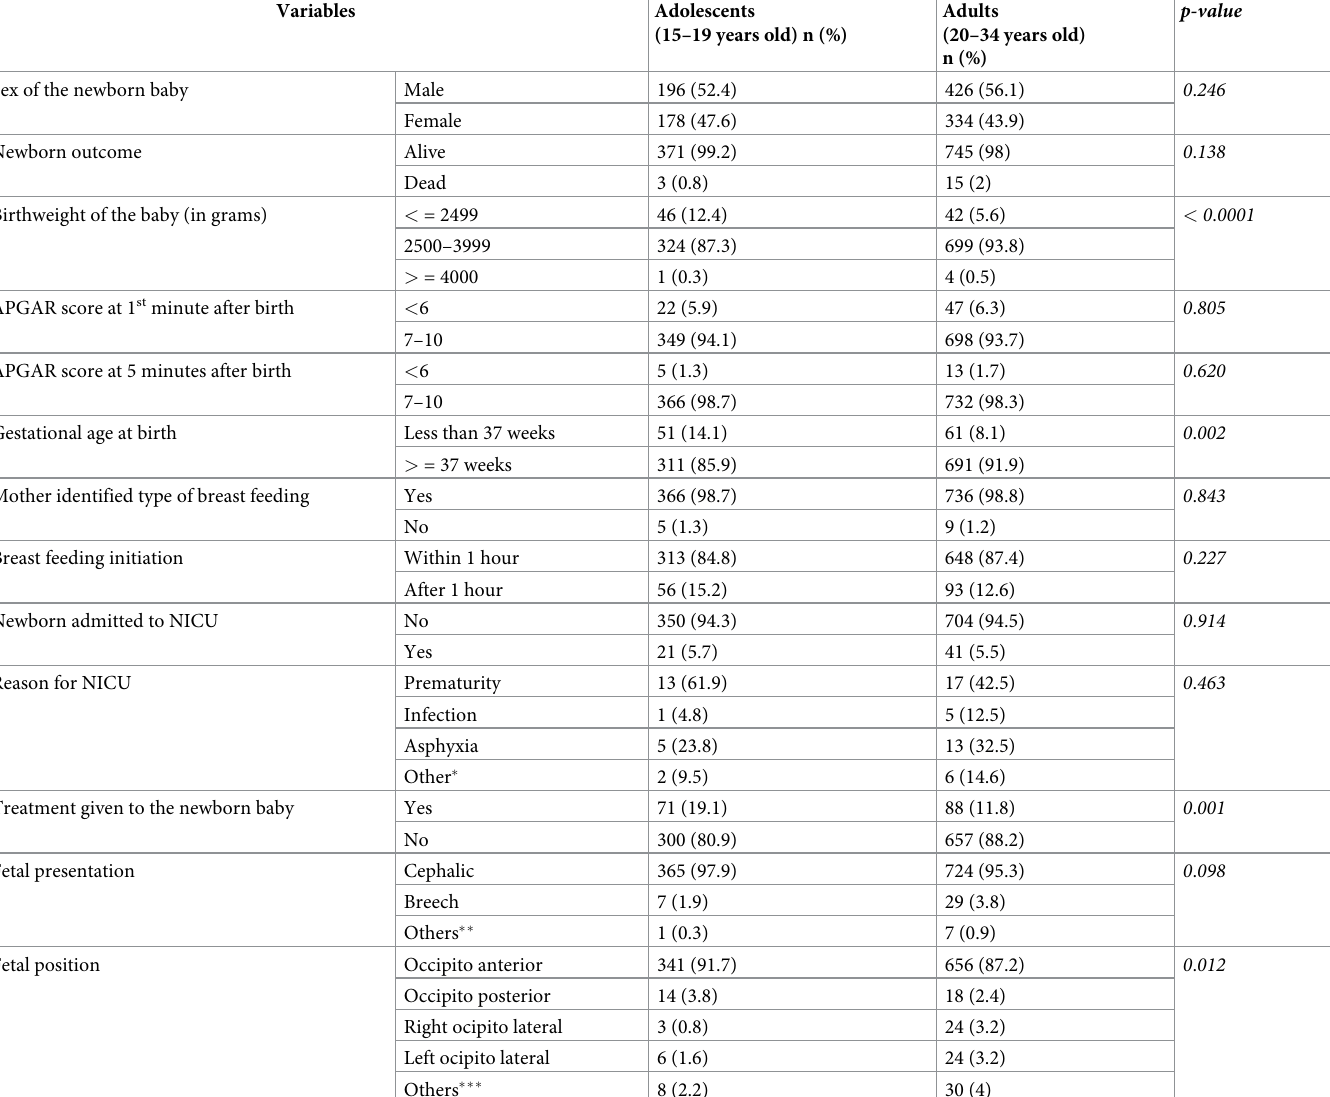
Table 3. Newborn characteristics of women who gave birth at public health facilities in East Gojjam zone, Northwest Ethiopia,